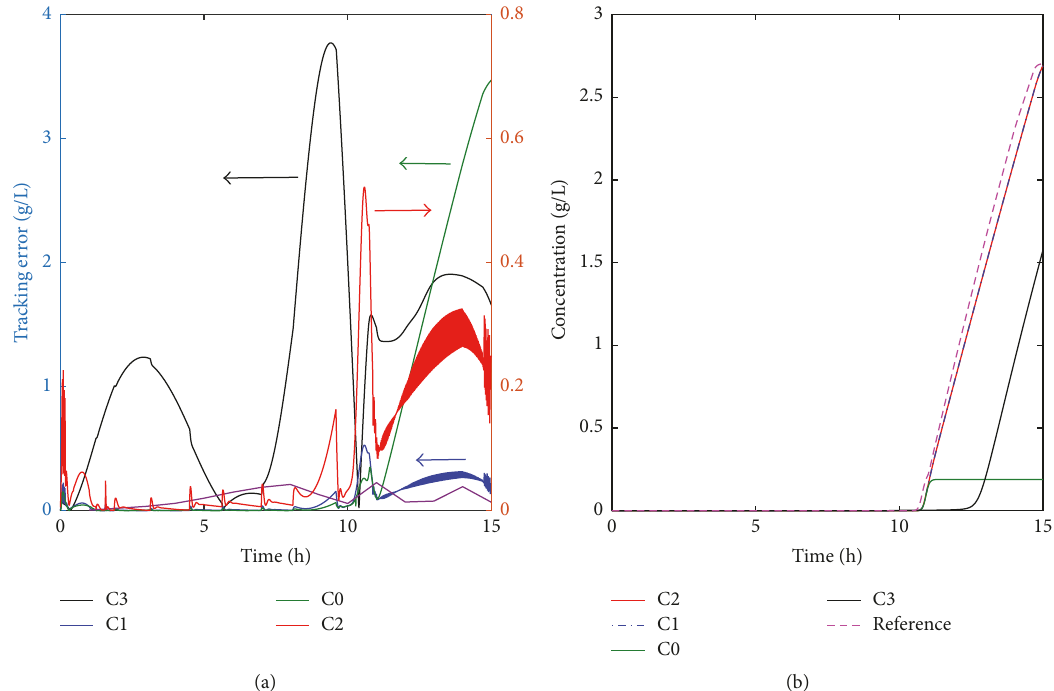
Figure 4: (a) Comparison of the tracking errors (see (31)) under uncertain nonlinearities in 𝜇 (left ordinate axis: C0, C1, and C3; right axis: C2). (b) Total protein concentration